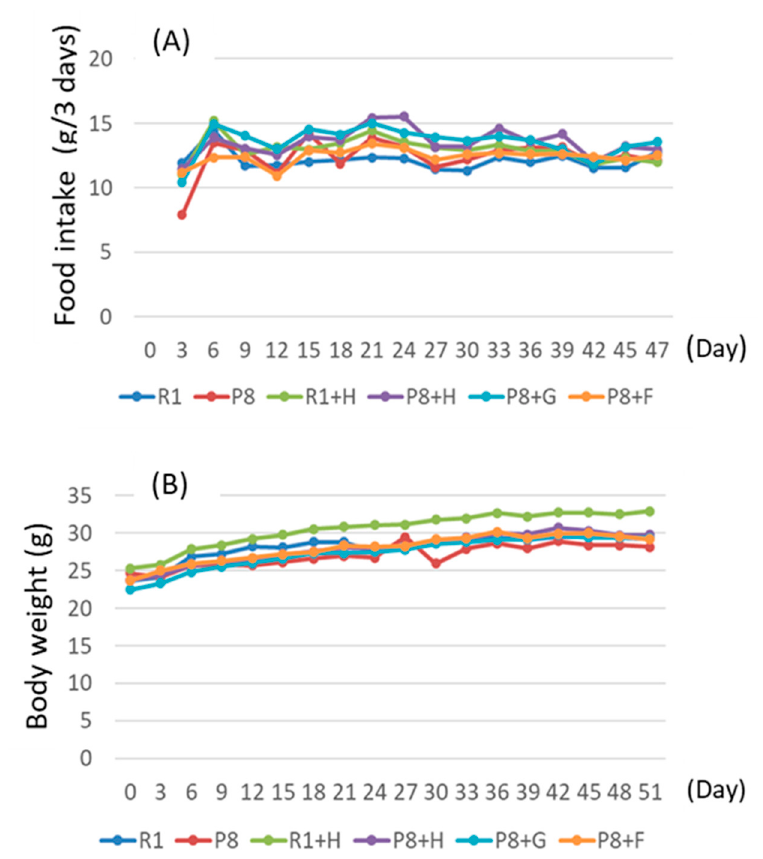
Figure 1. Food intake every 3 days ( A ) and changes in body weight gain ( B ) in mice given peanut wholegrains, germ-rich fractions, and ferulic acid. R1: senescence-accelerated resistant mice (SAM-R1) group fed with basal diet; P8: senescence-accelerated mouse prone / 8 (SAMP8) group fed with basal diet; R1 + H: SAM-R1 group fed with basal diet with added peanut wholegrains; P8 + H: SAMP8 group fed with basal diet with added peanut wholegrains; P8 + G: SAMP8 group fed with basal diet with added germ-rich fraction of wholegrain; P8 + F: SAMP8 group fed with basal diet with added ferulic acid. Food intake every 3 days and body weight are the means of each group.